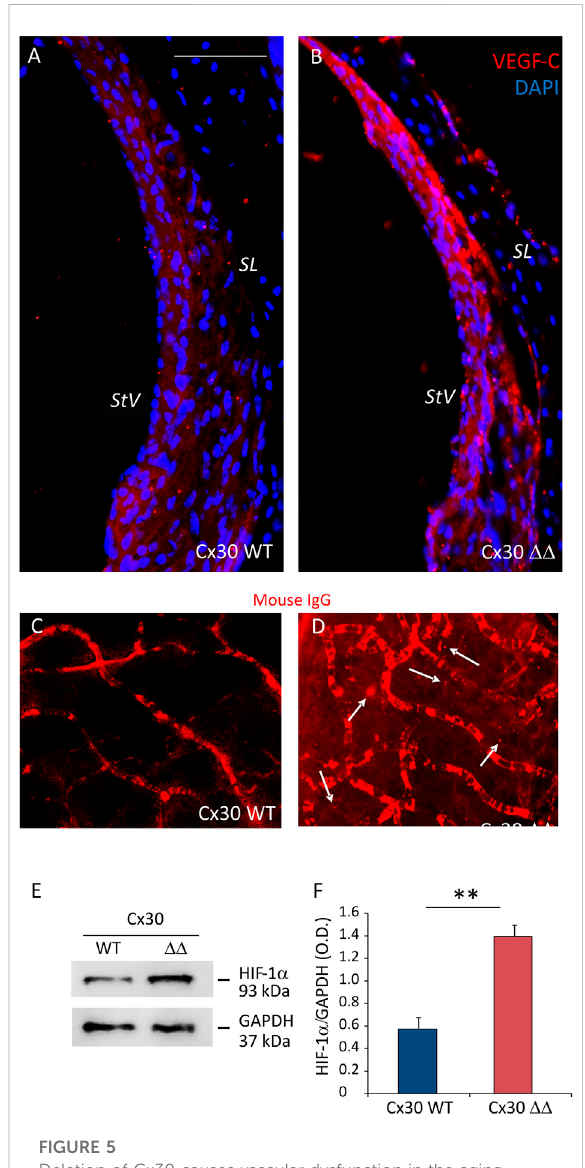
cochlea. (A and B) : Immuno fl uorescence analysis of VEGF-C (red fl uorescence) in the stria vascularis of Cx30 WT and Cx30